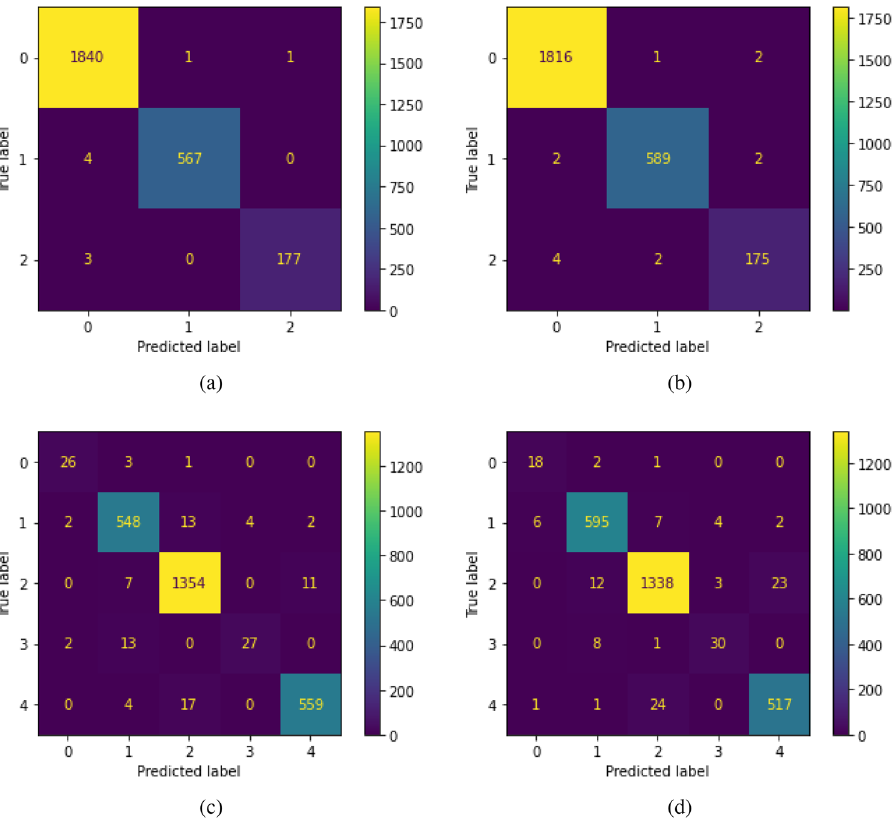
Figure 1. Confusion matrices for ensemble and ANN models. Ensemble matrices are on the left, panels ( a ) and ( c ), while ANN matrices are on the right, ( b ) and ( d ). DNA classification is on the top, ( a ) and ( b ), with kingdom on the bottom, c and d . For DNA: 0 is nuclear, 1 is mitochondrial, and 2 is chloroplast. For kingdom: 0 is archaea, 1 is bacteria, 2 is eukaryotic, 3 is phage, and 4 is viral. Entries down the left-to-right downward diagonal indicate correct classification, while all other entries are